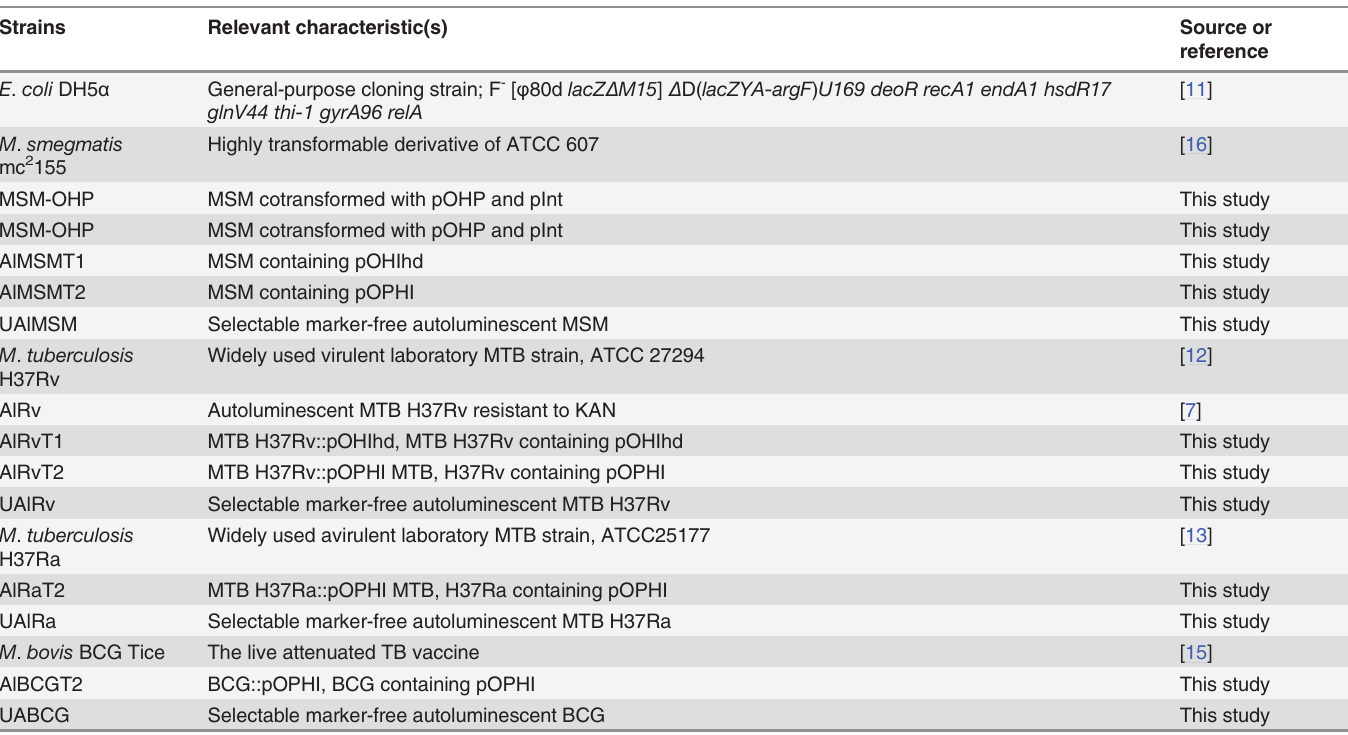
Table 1. Bacterial strains in this